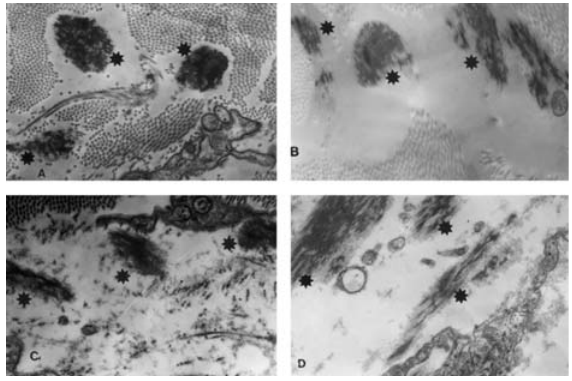
Figure5 -Skinultrastructuralmicrographstakenatanoriginalmagnifica- tion of x 8,000. (A) Irregular masses of dark elastic tissue in the reticular dermis of buttock skin from patient 1 compared to (B) buttock skin of a normal control individual matched for age and sex; (C) decrease in the amount of elastic fiber in torso skin from patient 2 in comparison with (D) controltorsoskinfromanormalregionofacontrolindividualmatchedfor age and sex.